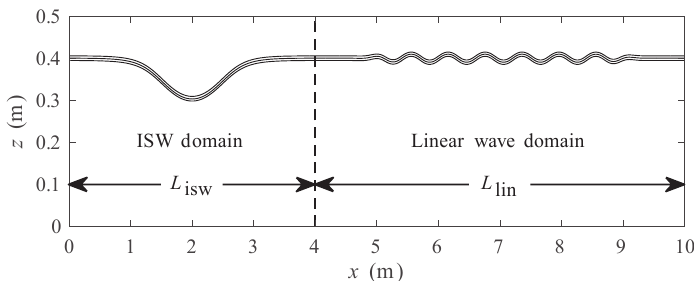
Figure 2. Graph of the model setup. Solid curves are isopycnals indicating the ISW and the linear waves in the initial field.